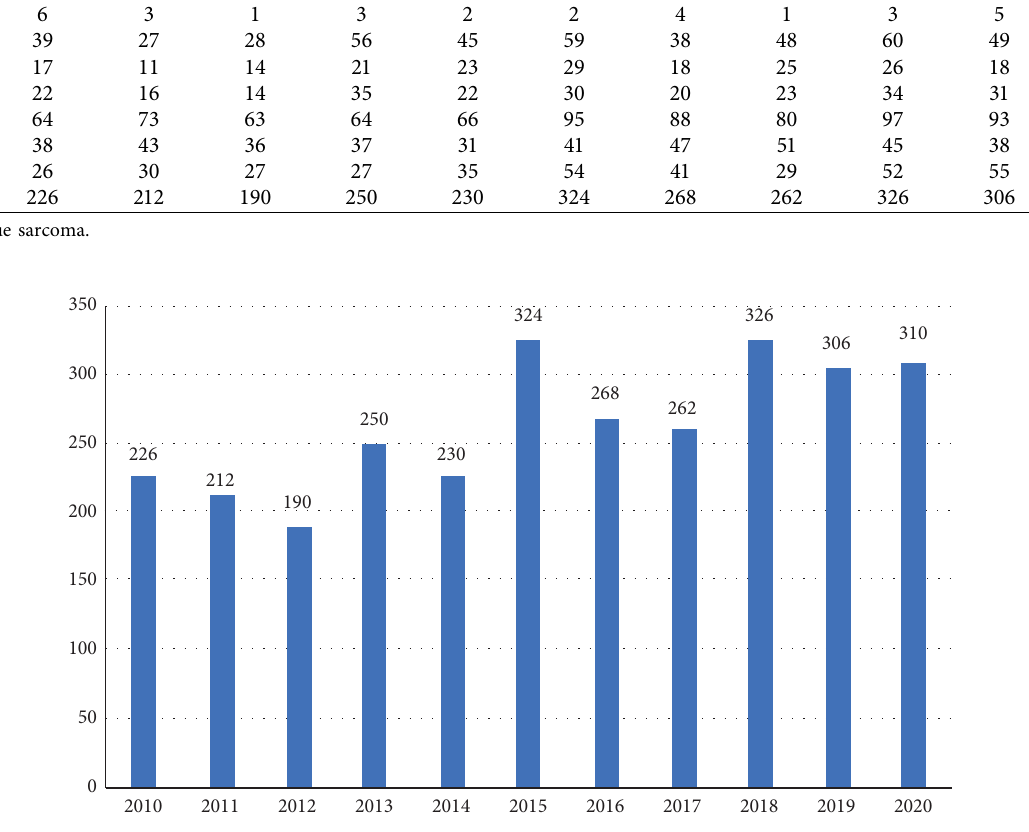
Figure 4: Total number of deaths per year due to